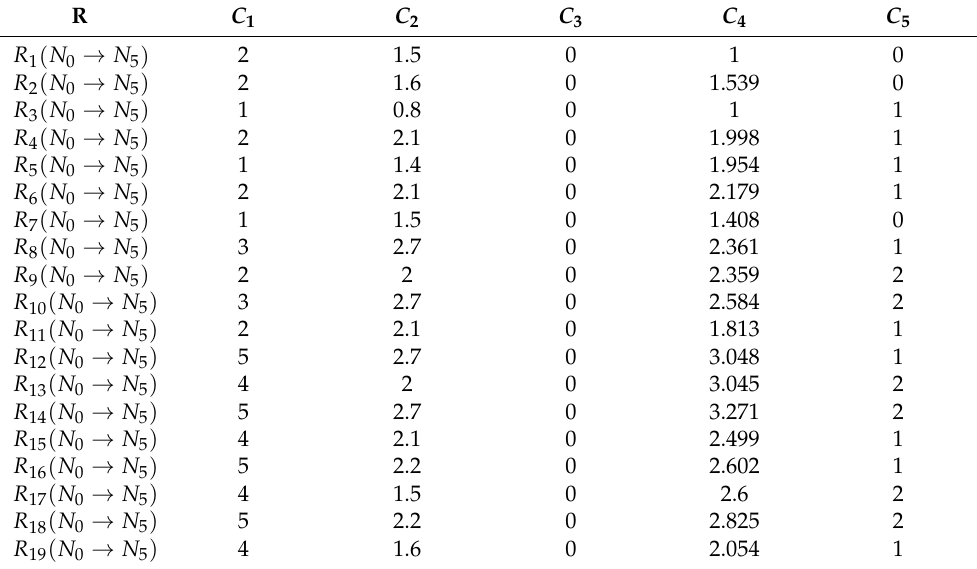
Table 3. The criteria values for the N 0 → N 5